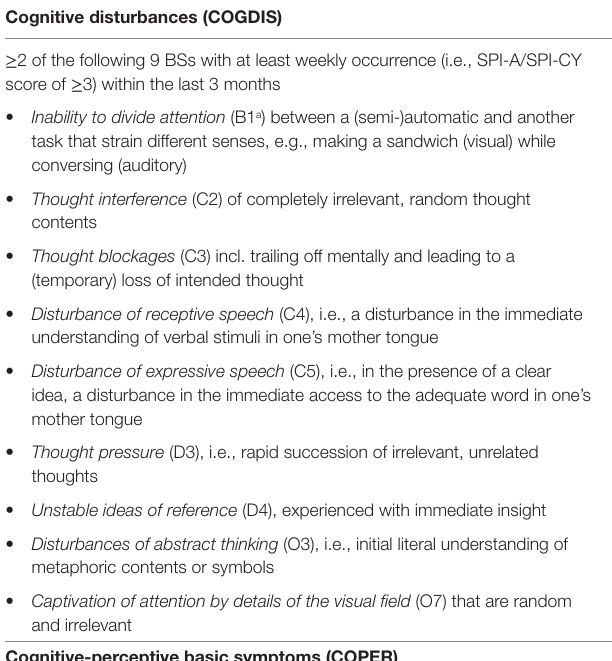
tABLe 1 | cHr criteria according to the Bss concept. cognitive disturbances